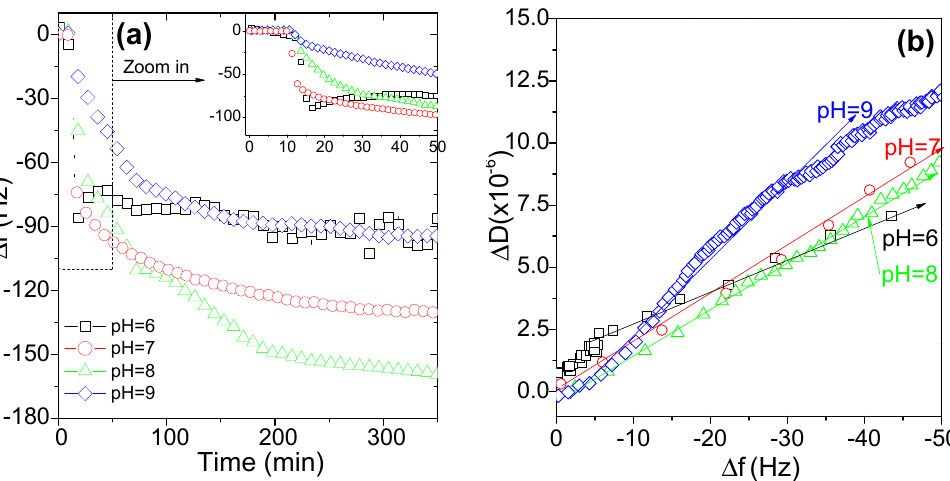
Figure 4. The adsorption behaviors of AmPAM on silica surface at different pH media ( a ) and the according conformation information revealed by the relationship of Δ D / Δ f ( b ). The tested AmPAM sample was of Mw of 336 k and the polymer concentration was 100 mg/L. Ionic strength of solution was controlled at 0.02 M.